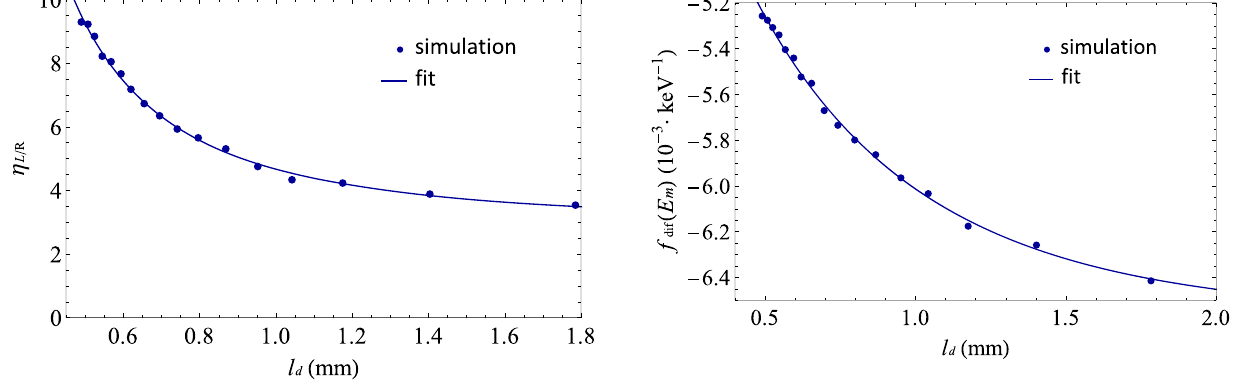
Fig. 5 Dependence of f dif ( E m ) on l d